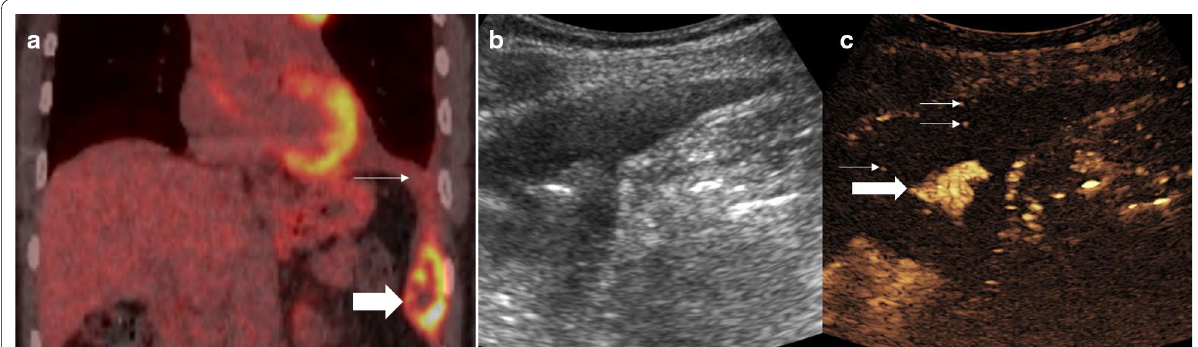
Fig. 9 Patient with metastatic squamous cell carcinoma. a PET‑CT examination shows a peripherally avid lesion in the costophrenic angle (arrow) with an associated pleural effusion (thin arrow). b , c Simultaneous B mode and CEUS images post‑biopsy shows pooling of the UCA within the pleural effusion (thick arrow) which was static on dynamic imaging and single microbubbles (thin arrow) within the otherwise anechoic effusion. The findings are of post‑biopsy haemorrhage which ceased without